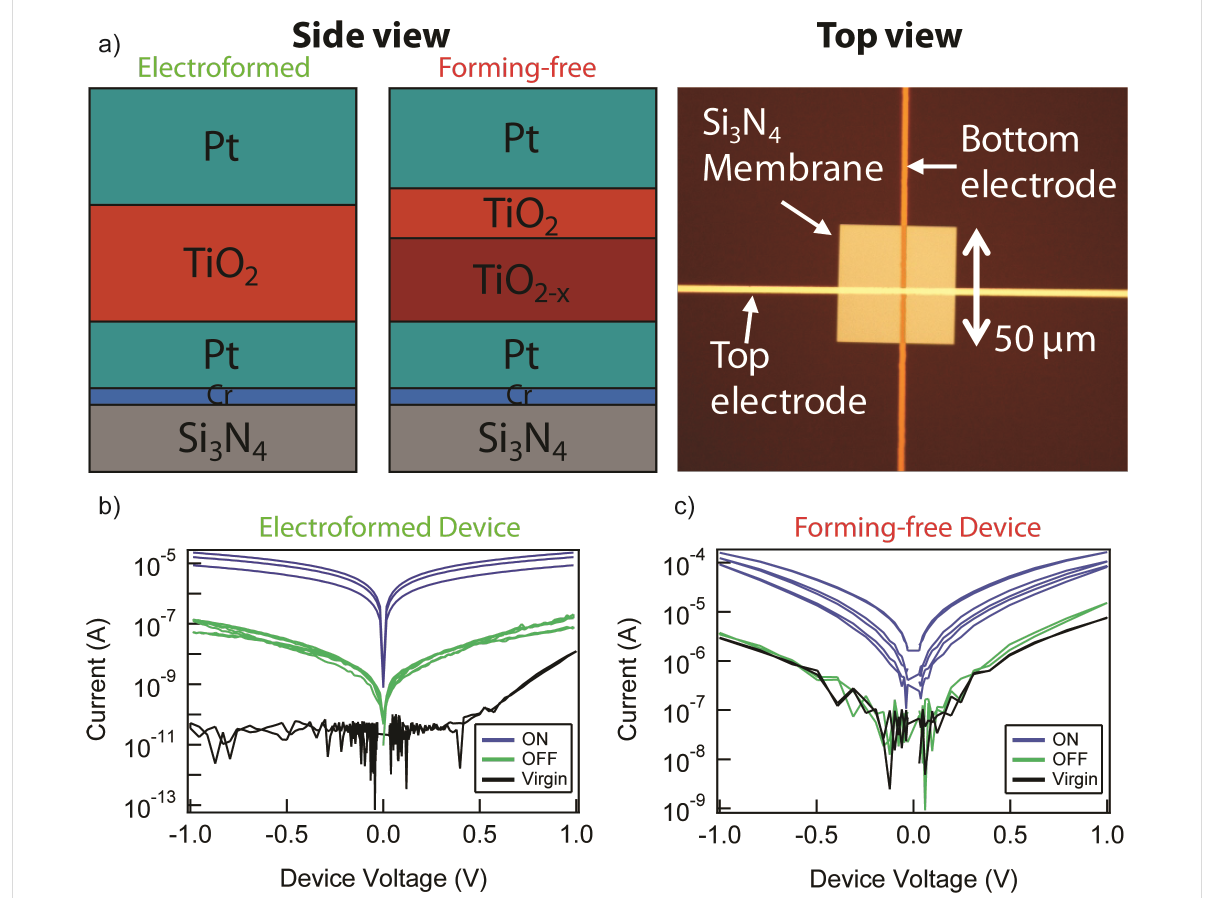
Figure 1: (a) Device schematics from side and top views for the electroformed (left panel) and forming-free (center panel) structures. A top view (right panel) shows the free-standing membrane allowing X-ray transmission measurements. Electrical characterization of (b) normal Pt/TiO 2 /Pt and (c) double layer Pt/TiO 2 − x /TiO 2 device, showing the Virgin, OFF (high resistance), and ON (low resistance) states. The normal device exhibits an irre- versible forming step, while the double layer structure is able to regain the Virgin state when turned